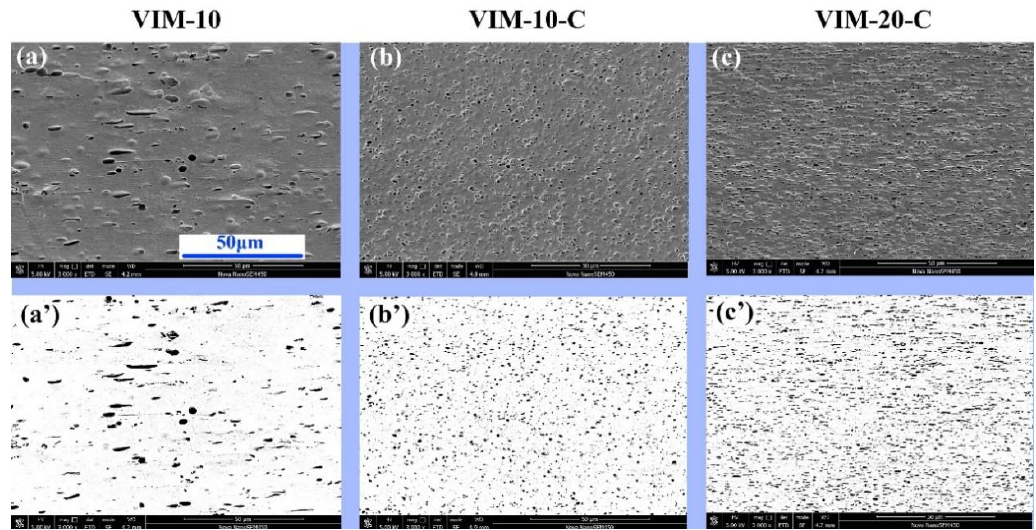
Figure 6. Phase morphology of the immiscible blend. First row is the original SEM photo while second row is the modified picture for the convenience of clear observation. Flow direction is horizontal.